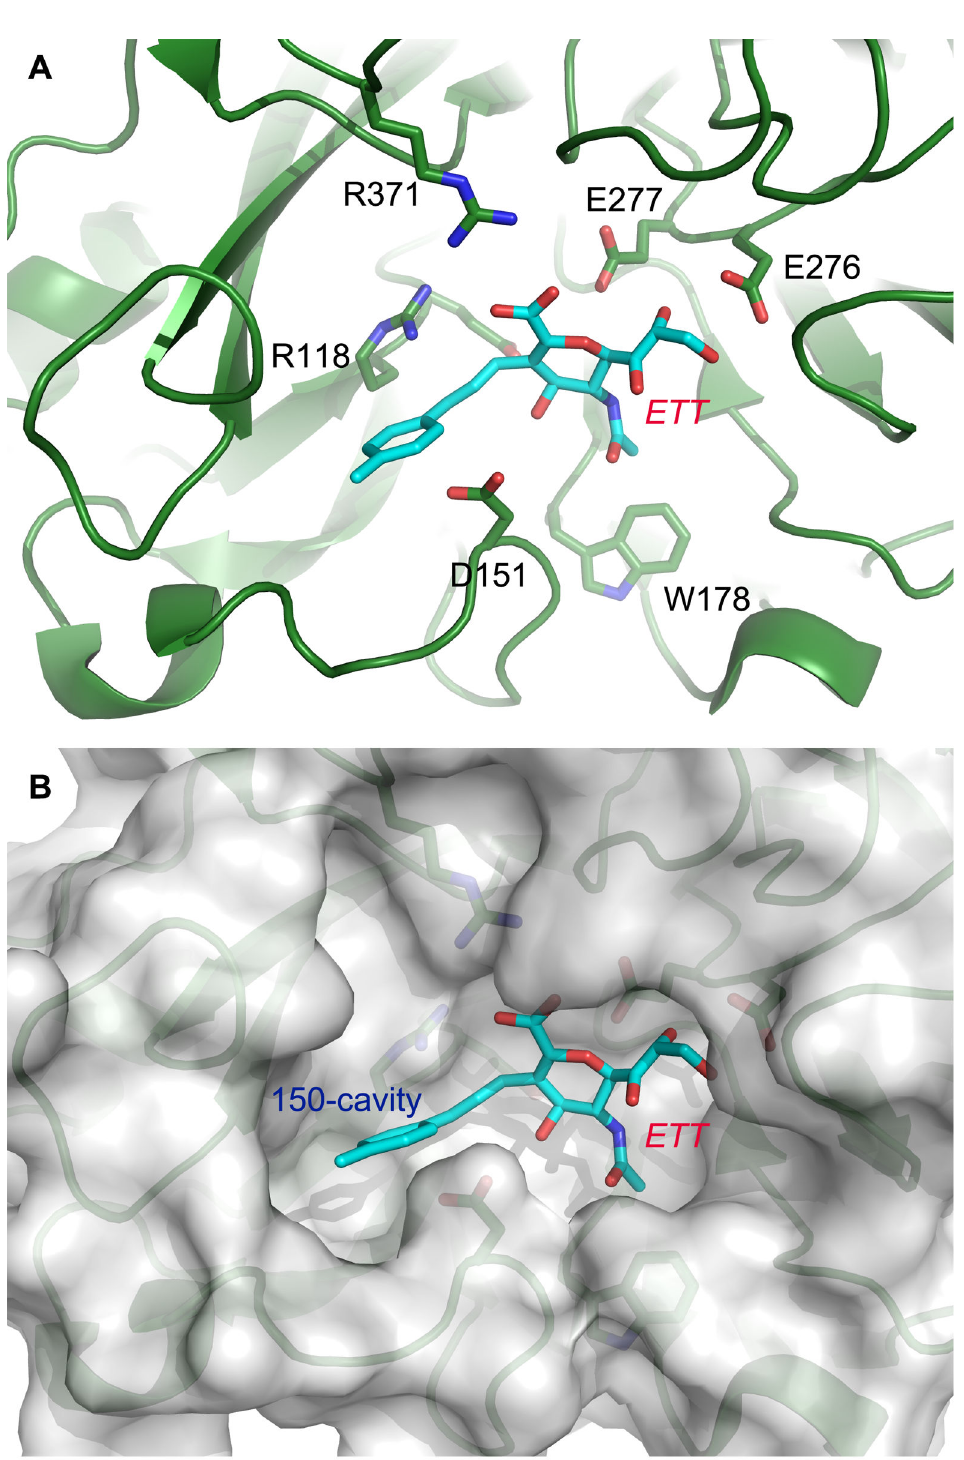
Figure 11. Crystal structures of N8 and ETT complex. The complex is shown in cartoon. ETT is colored in cyan. Nearby active residues are shown in stick representation in panel A. The surface of N8 was calculated for a better illustration of the 150-cavity.